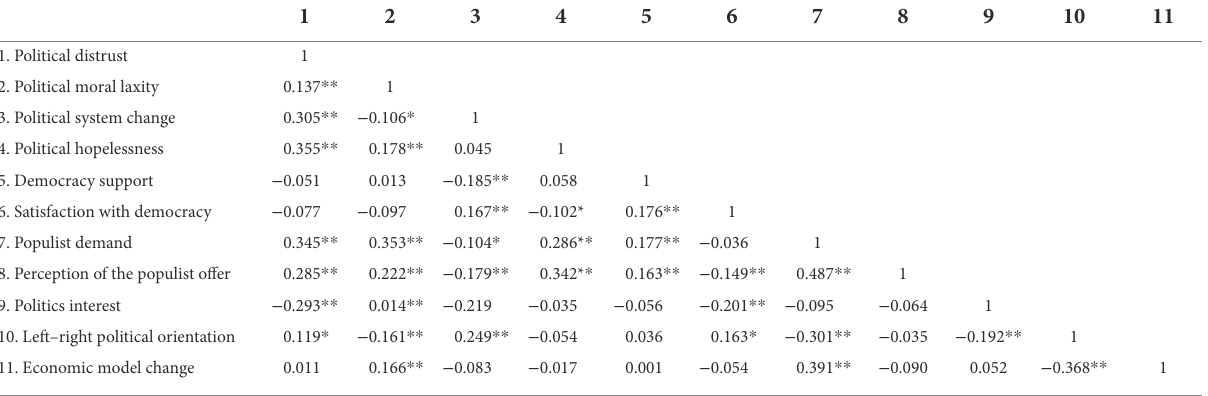
TABLE 2 Correlations between the dimensions of political cynicism, attitudes toward democracy, socio-political characteristics and